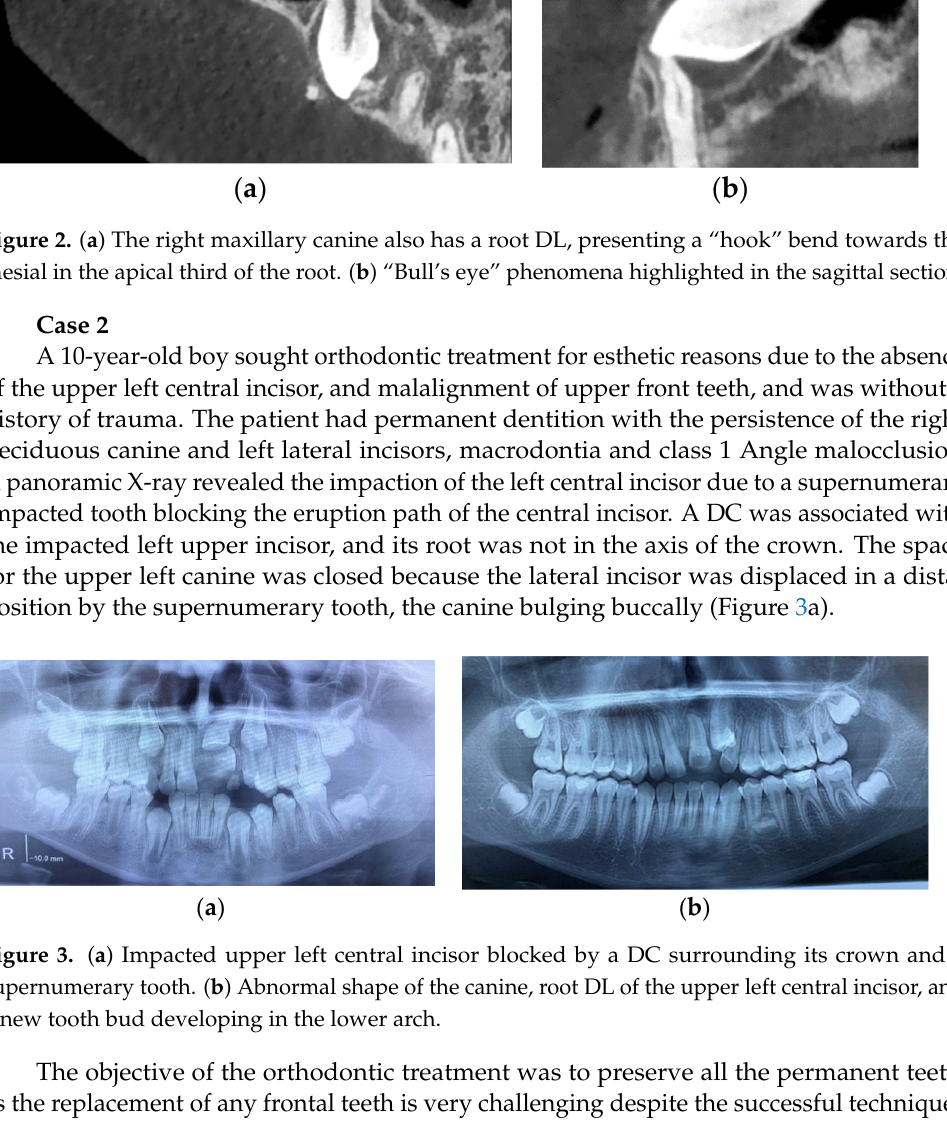
Figure 3. ( a ) Impacted upper left central incisor blocked by a DC surrounding its crown and a su- pernumerary tooth. ( b ) Abnormal shape of the canine, root DL of the upper left central incisor, and a new tooth bud developing in the lower arch.